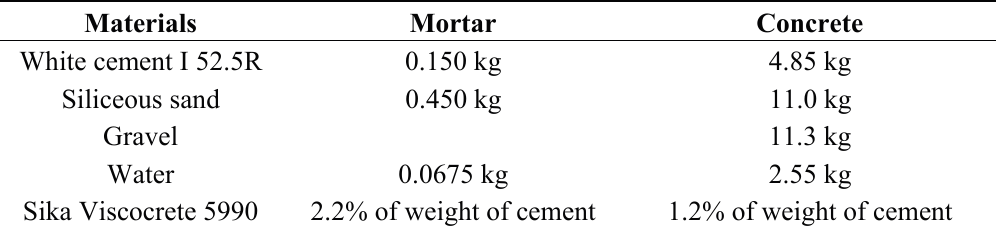
Table 1. Mix proportions of mortar and concrete.